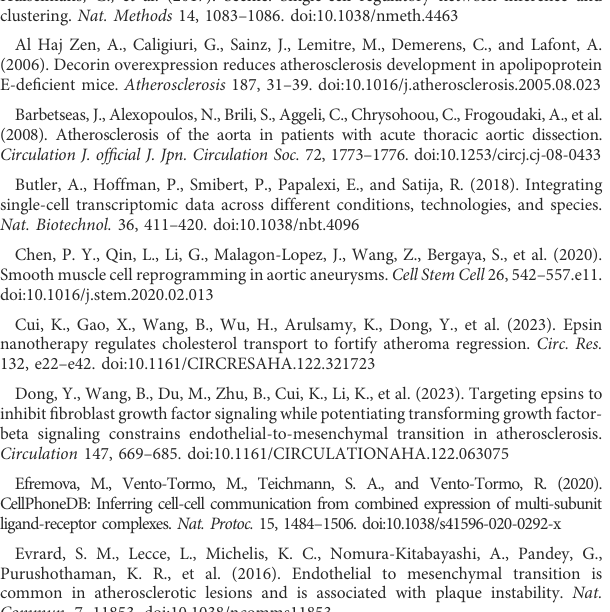
SUPPLEMENTARY FIGURE S1 GOand KEGGanalysis ofdifferentiallyexpressedgenes. (A) Dot plotshowing the z-score scaled average expression levels of hallmarks used for identi fi cation of cell types. (B) The gene ontology (GO) and pathway analysis results of differentially expressed genes using Metascape. (C) Circle plot showing the GO annotations related to atherosclerosis. (D) The pathways and genes enriched by KEGG analysis. The p.adjust represents Benjamini-Hochberg adjusted p value. SUPPLEMENTARY FIGURE S2 Single cell data set analysis of arterial tissue in atherosclerotic human. (A) t-SNE plots showing cell type clusters of arterial tissue from atherosclerotic human. The fi broblasts are circled in red. (B) Violin plots of markers differentially expressed in cell type clusters. (C) Feature plots showing the global expression level of marker genes (Dcn,Col1a1,Col3a1) and SERPINF1 in the fi broblasts. The fi broblasts are circled in red. The analysis data comes from GSE155514 (GSM4705589, GSM4705590, GSM4705591). SUPPLEMENTARY FIGURE S3 Single cell data set analysis of arterial tissue in atherosclerotic mice. (A) t-SNE plots showing cell type clusters of mice on normal and western diet. The fi broblasts are circled in red. (B) Violin plots of markers differentially expressed in cell type clusters. (C) Feature plots showing the global expression level of marker genes (Dcn,Col1a1,Col3a1) and Serpinf1 in the fi broblasts. The fi broblasts are circled in red. (D) Histogram of Serpinf1 gene expression in atherosclerotic mice at different periods. p value is calculated by Kruskal-Wallis test. The analysis data comes from GSE216579 (12WK:GSM6680846), GSE214413 (Normal aorta: GSM6605449; 16WK:GSM6605451), GSE155514 (8WK: GSM4705600, GSM4705601; 16WK: GSM4705603, GSM4705604; 22WK: GSM4705605, GSM4705606). SUPPLEMENTARY FIGURE S4 Bulk RNA-seq analysis and gene set enrichment analysis. (A,B) Heat map showing the z-score scaled relative expression levels of differentially expressed genes. (C) Signaling pathways enriched by gene set enrichment analysis. P values are estimated by an empirical phenotype-based permutation test. (D) A schematic diagram to explain the increase in the proportion of fi broblast-like cells. (E) Simple mechanism diagram reveals that SERPINF1 participates in arterial plaque formation and rupture by regulating vascular